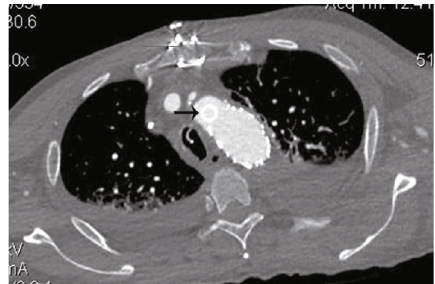
Figure 3: The proximal end of the chimney graft in the aortic arch.